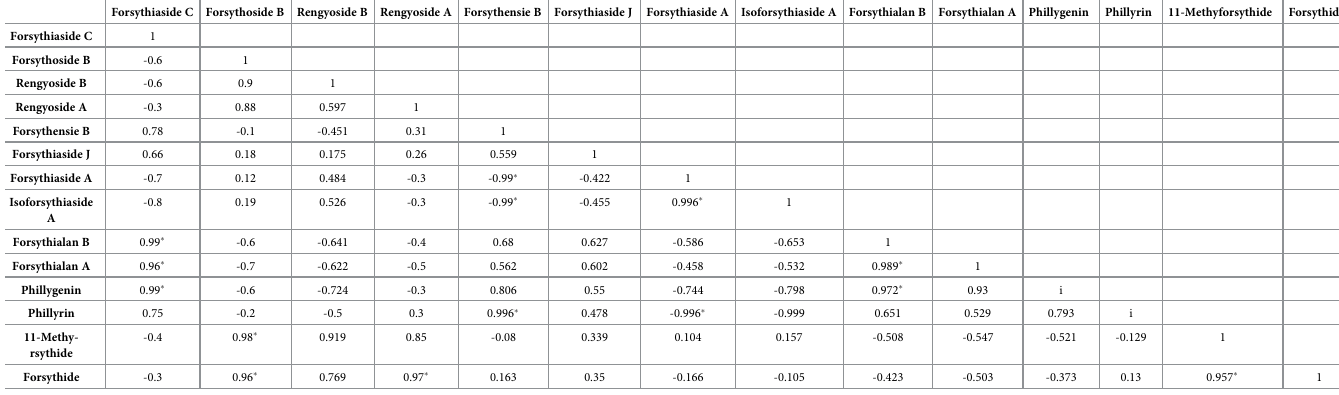
Table 2. Correlation analysis of Forsythia related metabolites in fruits of Forsythia